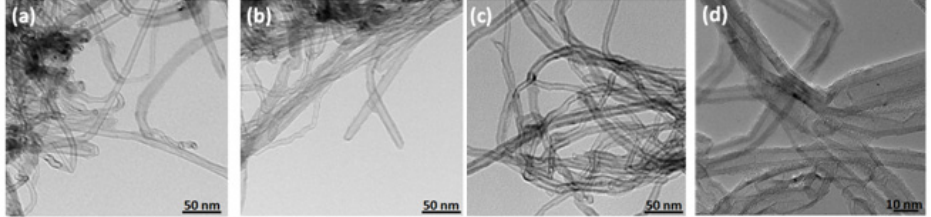
Figure 5. TEM images of pristine MWCNTs ( a ), chemically modified MWCNTs ( b ) and chemically modified MWCNTs with adsorbed doxorubicin ( c , d ).